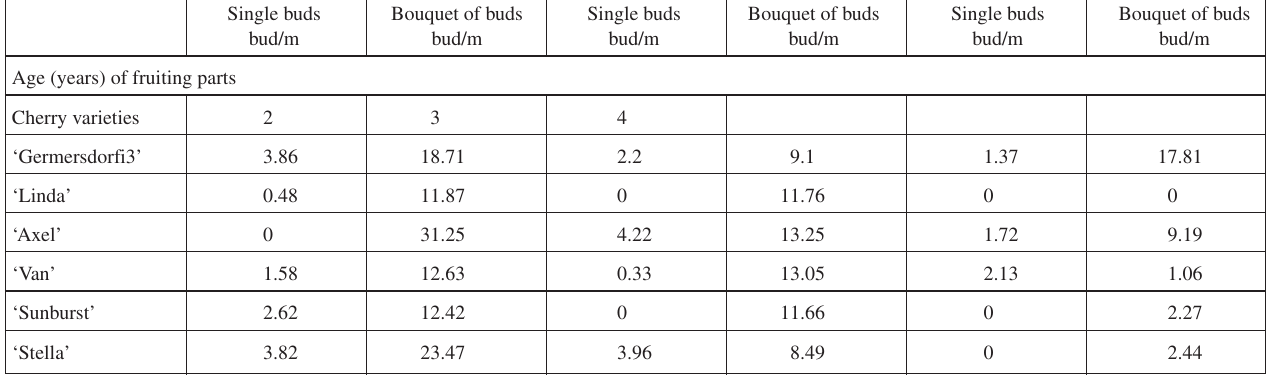
020406080100120140 Figure 1: Number of flowers on the fruiting bouquets of sweet cherry varieties (%) (Debrecen-Pallag, 2009) Table 1. Fertility of different fruiting parts of different age in cherry varieties (Debrecen-Pallag, 2009) Single